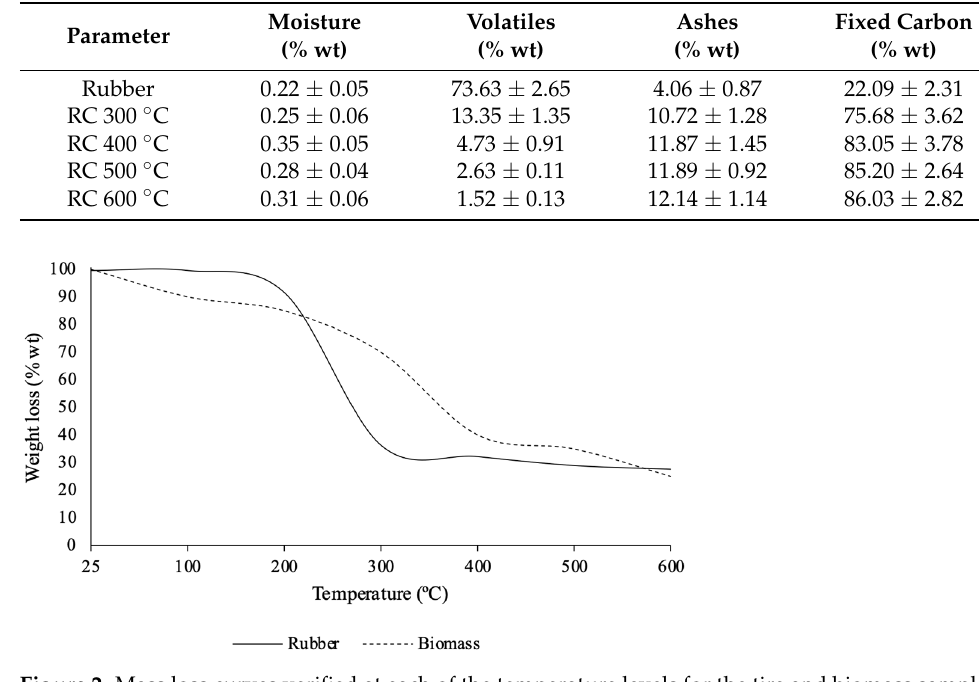
Figure 2. Mass loss curves verified at each of the temperature levels for the tire and biomass samples.